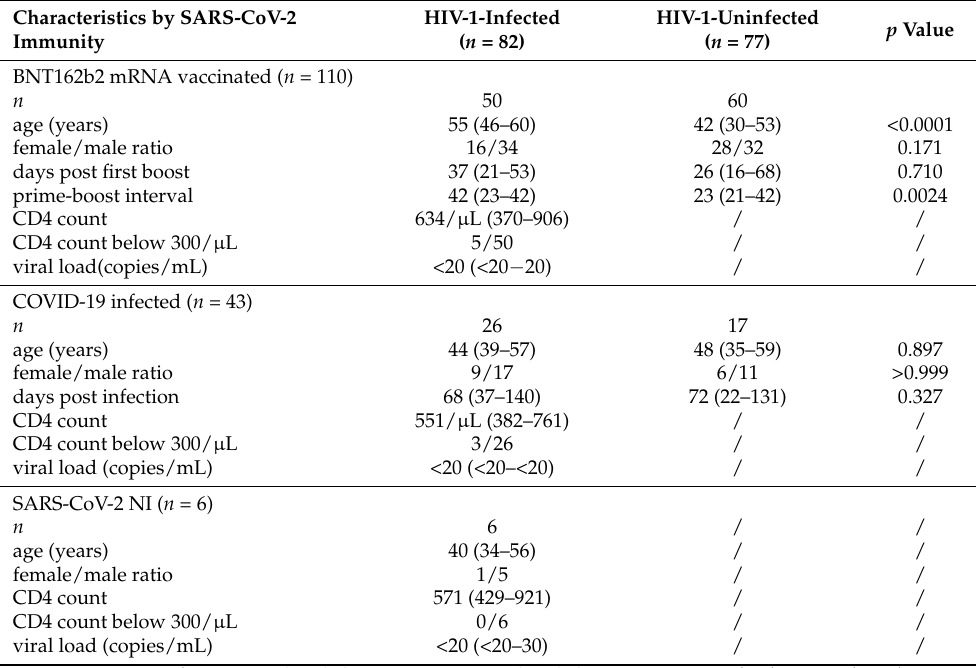
Table 1. Characteristics of the study